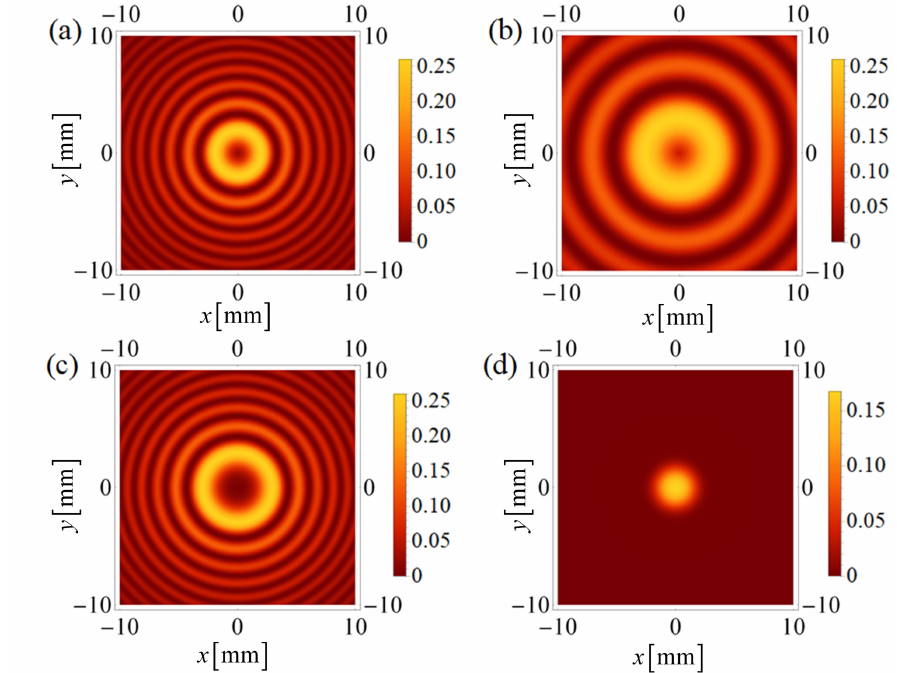
Figure 2. Intensity distribution for Airy beams in a vacuum of different beam parameters. Compared with ( a ) ω 0 = 1 mm, r 0 = 1 mm, a = 0.05, the different parameters in ( b – d ) are: ( b ) ω 0 = 2 mm, ( c ) r 0 = 2 mm and ( d ) a =